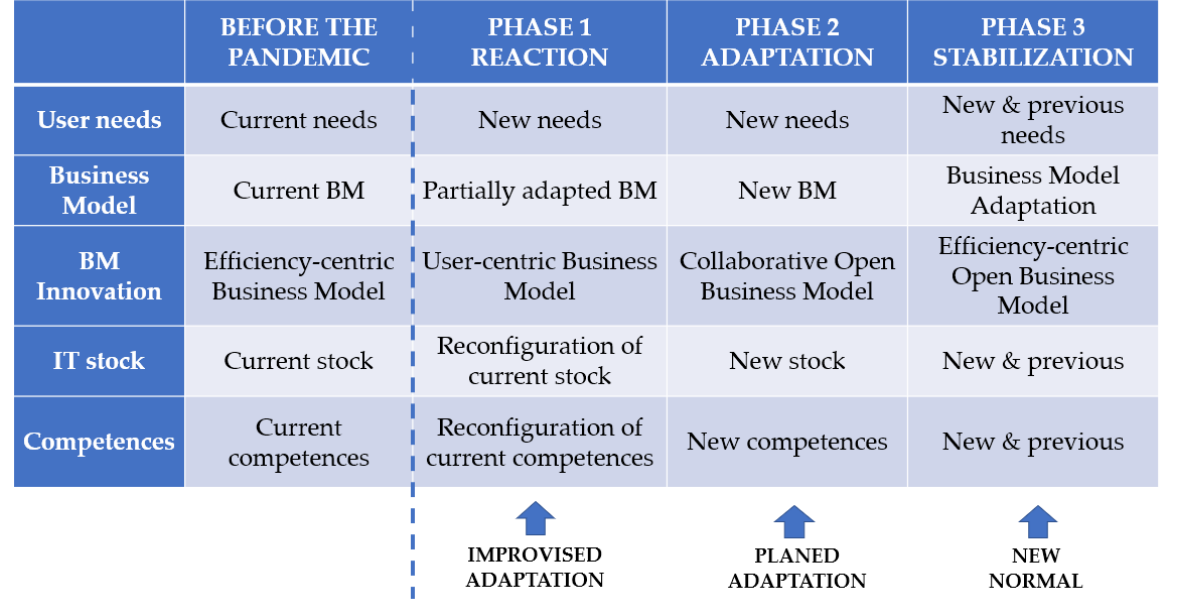
Figure 1. The three phases of business model adaptation in the cultural and creative industry.